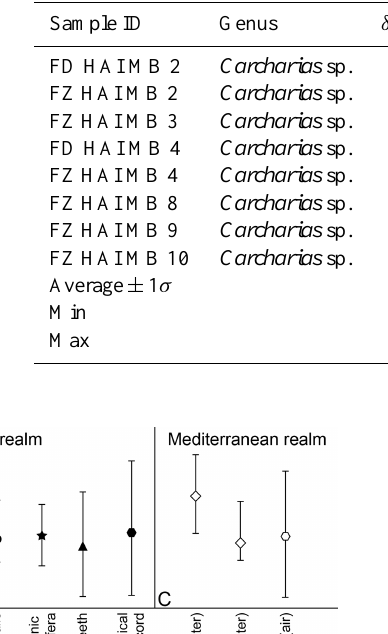
values (VSMOW) of shark teeth recovered from the Early Oligocene deposits of the Mainz Basin Table 3. Dentine and enamel δ 18 O PO 4 ) using the paleothermometry equation by Longinelli and Nuti (1973) (Tütken, 2003). Values have been converted to temperature ( T δ 18 O PO 4 assuming δ 18 O water =− 0.9‰.